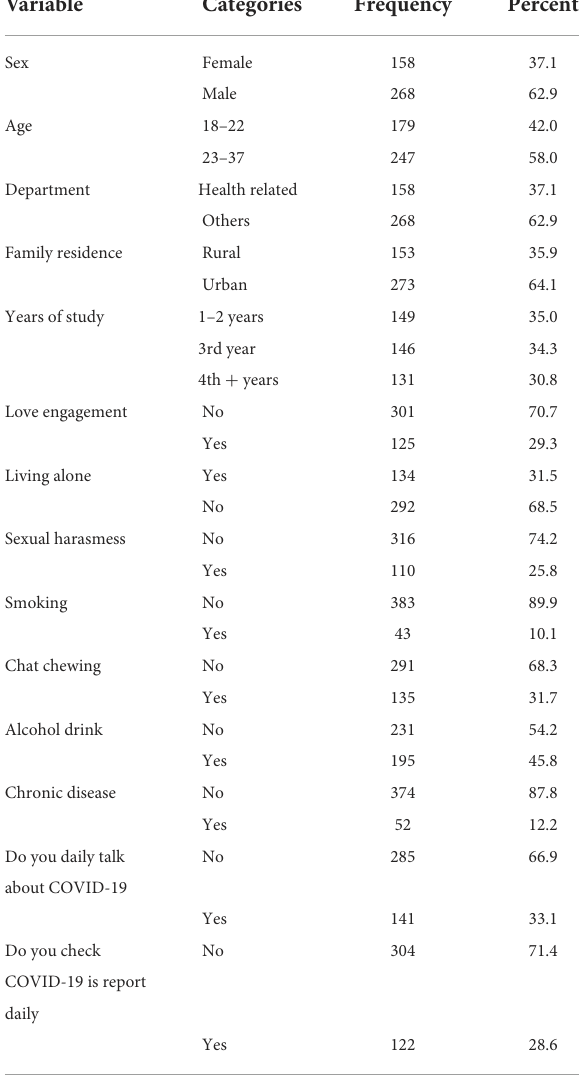
TABLE 1 Socio-demographic characteristics of study participants among university students in Ethiopia, 2021 ( n = 426).